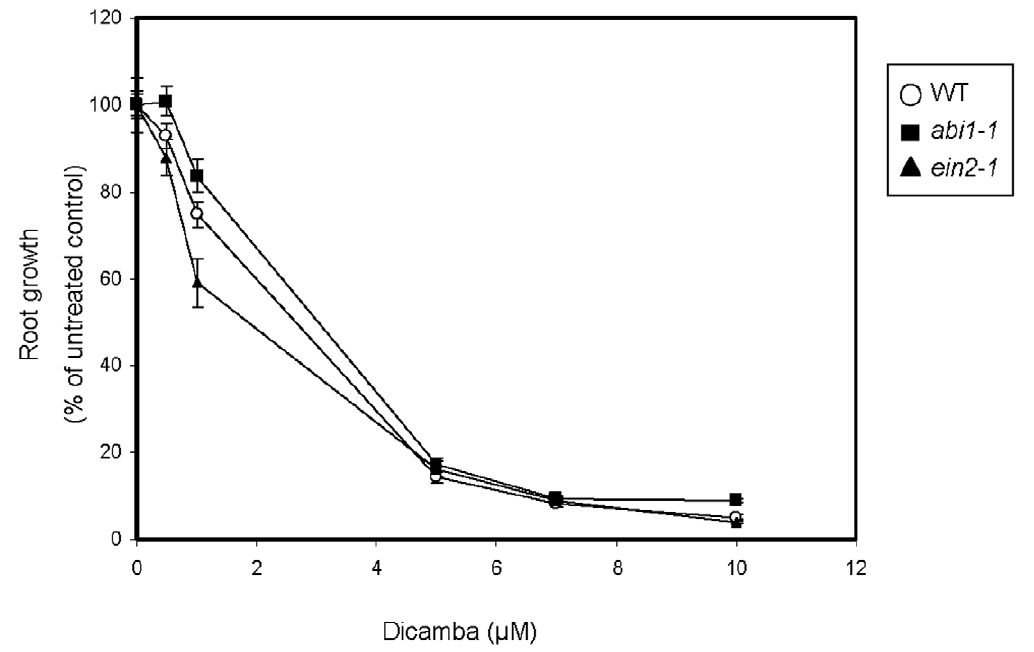
Figure 3. Effects on WT, abi1-1 and ein2-1 root growth as dicamba concentrations increase. Root growth measured after 8 days on MS- media containing 0, 0.5, 1, 5, 7 or 10 m M dicamba and transformed to a percentage of the average root length of the untreated control for each genotype. Measurements were taken on at least 20 seedlings of each line. (Error bars = standard error)